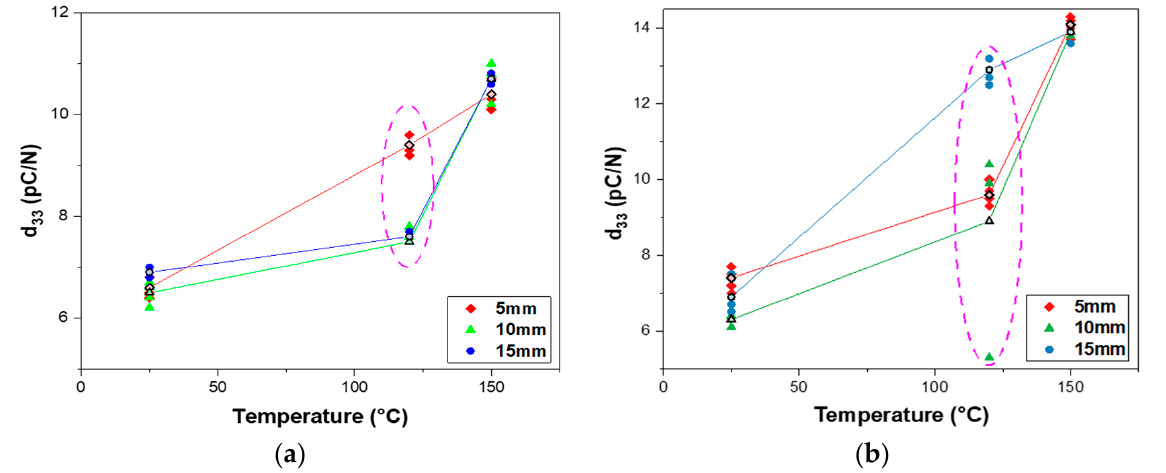
Figure 4. Piezoelectric charge coefficient d 33 of poled PZT–PVB composites versus poling temperature with various diameters of the electrodes: ( a ) alumina substrate; ( b ) mylar substrate.